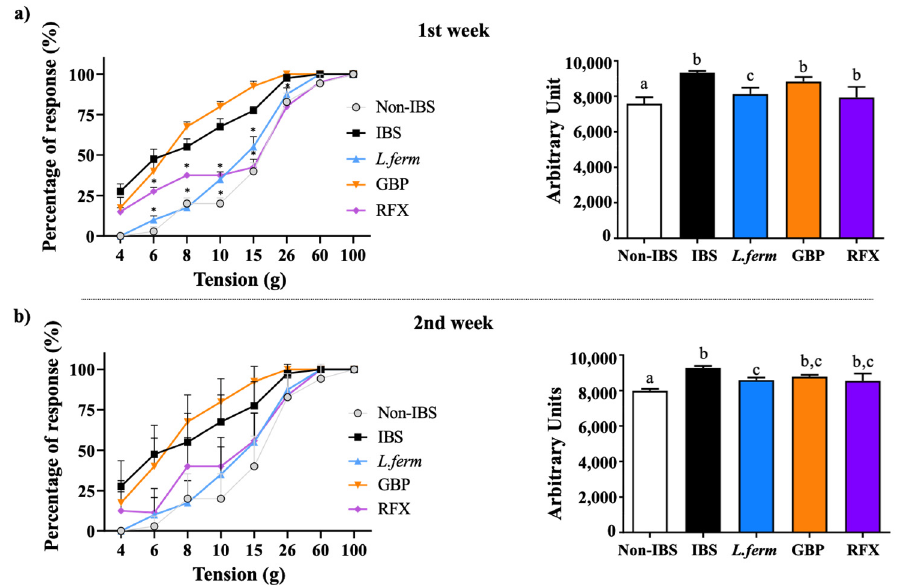
Figure 3. Evaluation of referred hyperalgesia one ( a ) and two ( b ) weeks after DCA instillation. Von Frey filaments (1–8 g) were applied to the abdomen of DCA vehicle (Non-IBS), 4 mmol/L DCA (IBS)-, L. fermentum (10 9 CFU) ( L. ferm )-, Gabapentin at 70 mg/kg (GBP)- and Rifaximin at 150 mg/kg (RFX)-treated rats. Referred hyperalgesia was calculated considering the percentage of response to filaments (number of animals responding to the filament) and area under the curve (AUC) was determined. Data are expressed as means ± SEM ( n = 10). * p < 0.05 vs. IBS group. Groups with different letters are statistically differ ( p < 0.05).